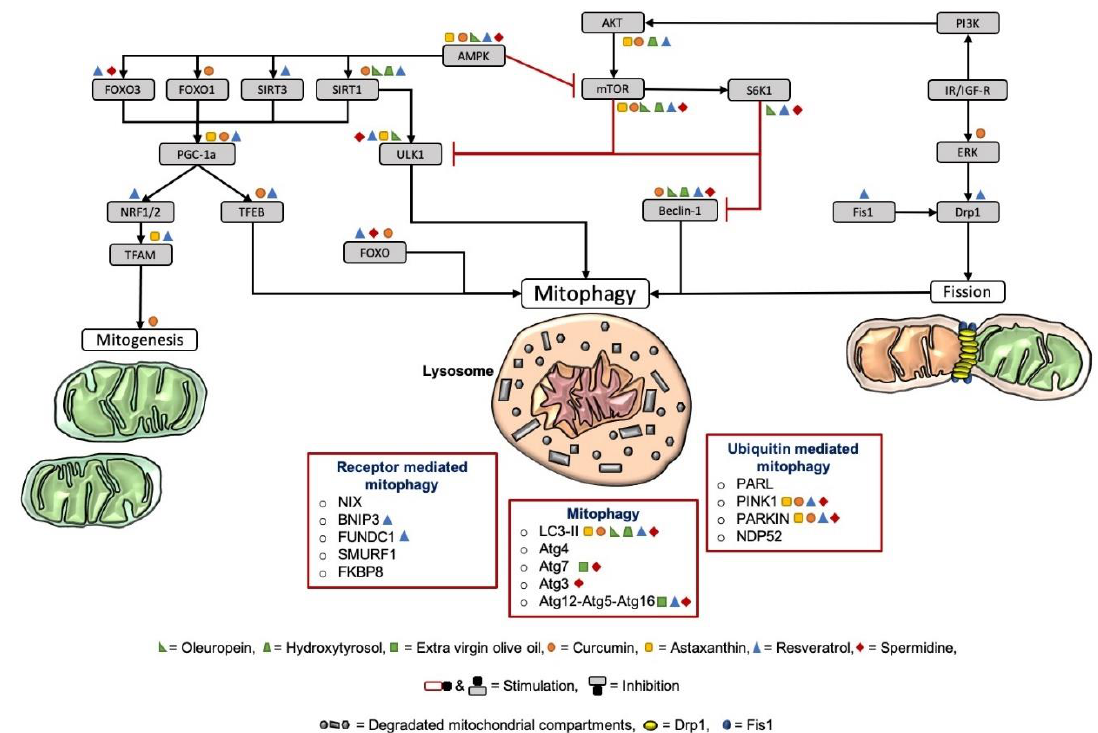
Figure 4. Target points of the dietary compounds on mitochondrial dynamics and mitogenesis, with a particular focus on mitophagy. AMPK is one of the central upstream regulators of mitophagy and mitogenesis. Through oxidative-stress, induced mtDNA mutation activates the AMPK pathway and further inhibits the mTOR [46]. AMPK, in turn, stimulates mitophagy via ULK1 and mitogenesis via the PGC-1 α pathway. The main upstream mediators of PGC-1 α are FOXO1 / 3 and SIRT1 / 3. PGC-1 α , in turn, activates mitophagy via NRF1 / 2 and TFAM. Paradoxically, the mitogenesis promoter PGC-1 α also interferes with mitophagy by regulating lysosomal biogenesis via TFEB. Further, AMPK targets FOXO1 and -3. FOXO, in turn, increases the transcription of essential mitophagy mediators and proteins. On the other hand, mTOR blocks mitophagy by inhibiting ULK1 as well as downstream signaling of ribosomal protein S6K1, which, in turn, also suppresses mitophagy by indirectly inhibiting ULK1 and Beclin-1. The upstream modulator of mTOR is the IR / IGF-R, which activates PI3K, followed by activation of AKT, which activates mTOR. ERK, in turn, phosphorylates Drp1 for mitochondrial fragmentation and stimulates mitophagy due to the activation of IR / IGF-R signals. In general, Fis1 is recruiting Drp1 to the OMM to induce mitochondrial fission. In this figure, the target points of the most prominent compounds of both the Mediterranean and the Asian / Okinawan diets are displayed. Hydroxytyrosol and oleuropein from olive oil, curcumin, astaxanthin, resveratrol, and spermidine were all found to stimulate mitochondrial dynamics, mitogenesis, and, especially, mitophagy. Abbreviation: AMPK = AMP-activated protein kinase; mtDNA = mitochondrial DNA;